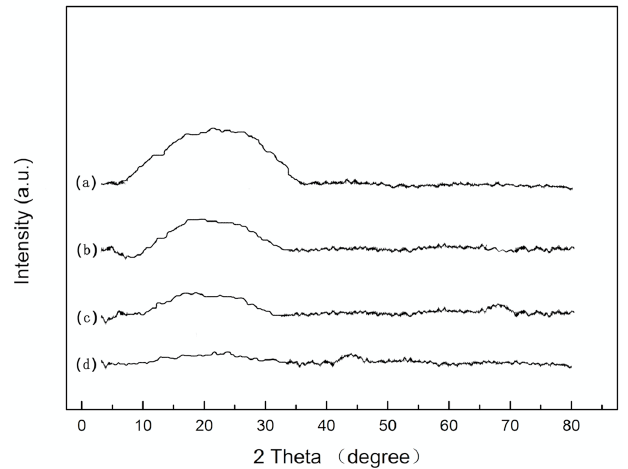
Figure 1. X-ray diffraction (XRD) analysis of silicon dioxide (SiO 2 ) coating with